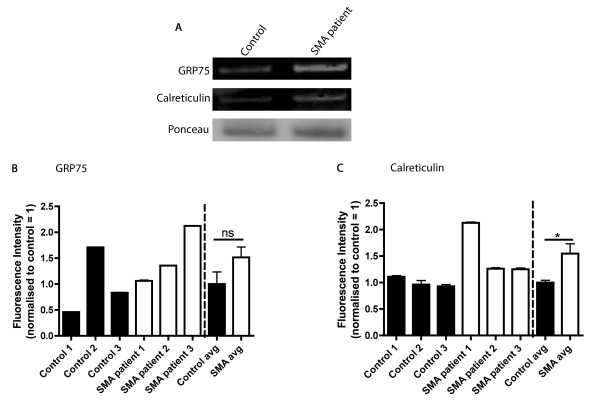
GRP75/Mortalin and Calreticulin are measurable in muscle biopsies from human SMA patients. (A) Representative fluorescent western blots on quadriceps femoris muscle biopsy samples from an SMA patient (type II/III) and an age-matched non-SMA control showing levels of GRP75/Mortalin, Calreticulin and Ponceau (loading control). (B,C) Bar charts showing expression levels of GRP75 and Calreticulin in human SMA patient muscle biopsies compared with controls. Data are shown for each individual patient (black and white bars to the left of the dashed line; error bars show variability between two independent measurements taken from that individual’s biopsy), as well as pooled mean for each patient group (right of the line; ± standard error of the mean; n = 6 measurements for each group, two independent measurements from each patient biopsy). (B) GRP75 levels showed a trend towards increased expression in SMA patients, but this difference did not reach statistical significance (ns, not significant; P > 0.05, unpaired, two-tailed t-test). (C) Calreticulin levels were significantly increased in SMA patient muscle (*P < 0.05, unpaired, two-tailed t-test).